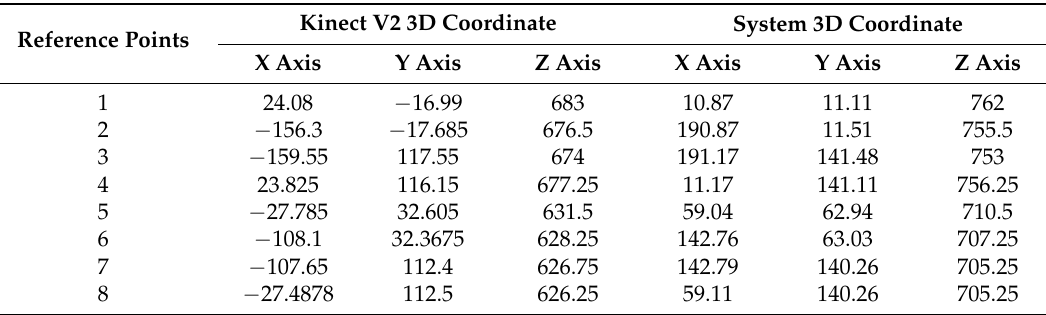
Table 2. The rectification coefficients based on the reference